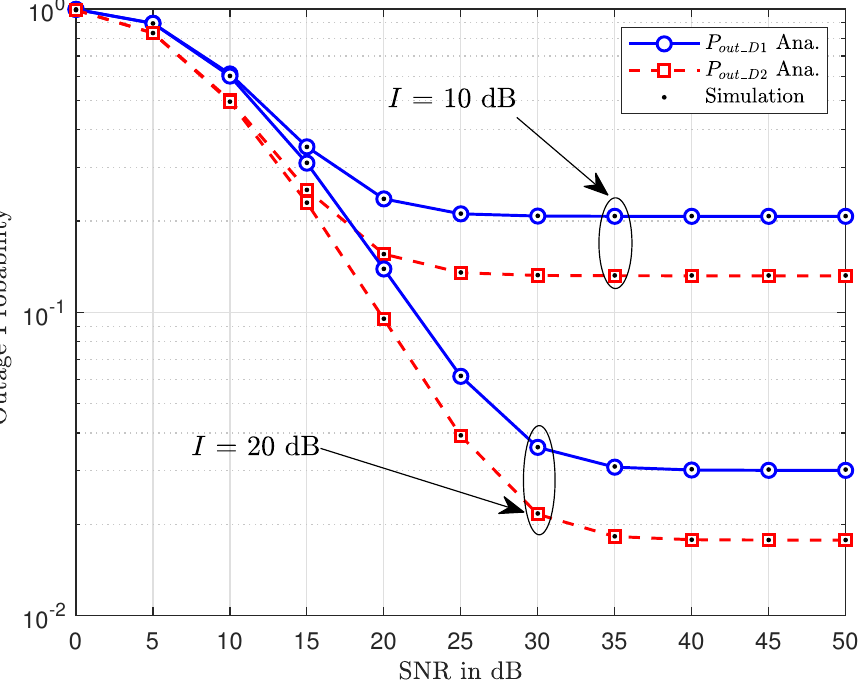
Figure 2. Outage performance of two vehicles versus SNR at the BS with different I